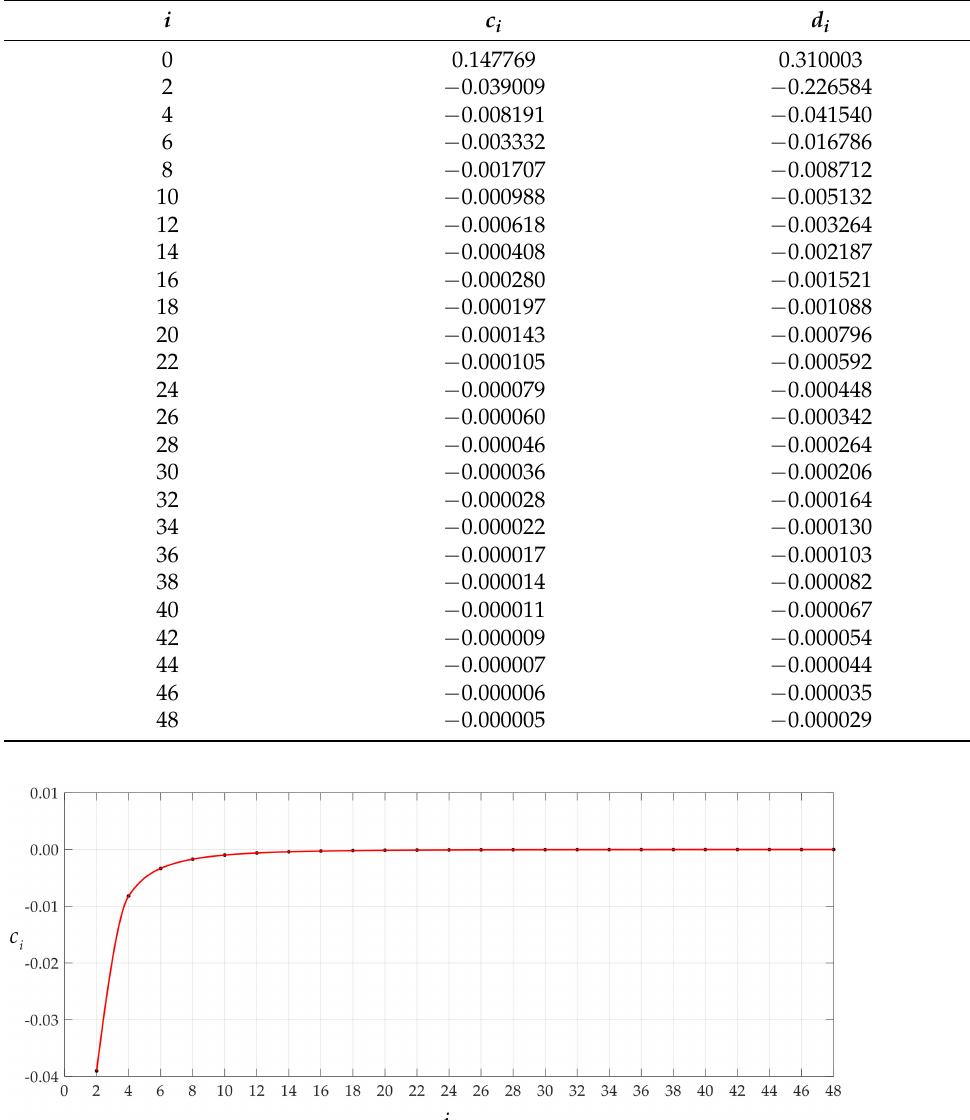
Table 2. Numerical values of c i and d i at different i when q = 0.003 MPa, c 0 = 0.147769 and d 0 = 0.310003.